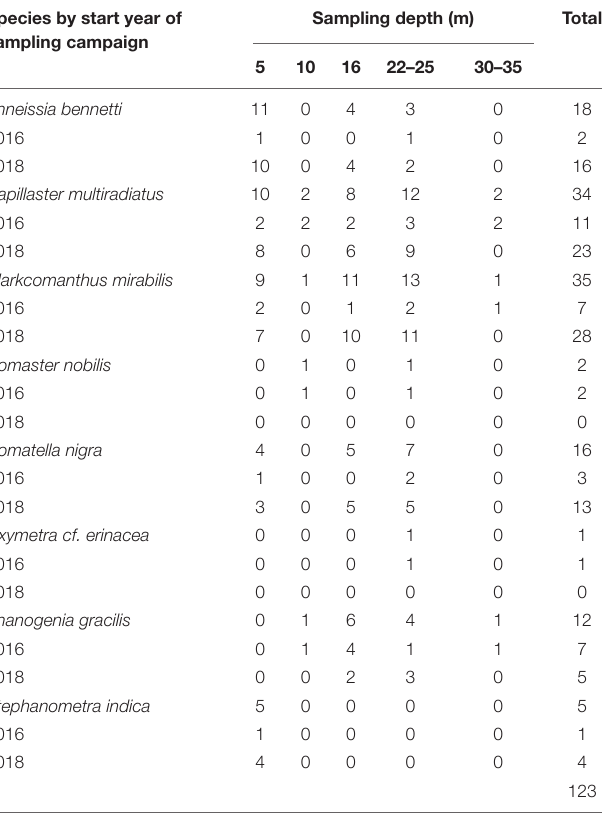
TABLE 2 | Summary of feather stars collected during two field campaigns starting in 2016 and 2018, in Malatapay, Negros Oriental, Philippines. Species by start year of sampling campaign